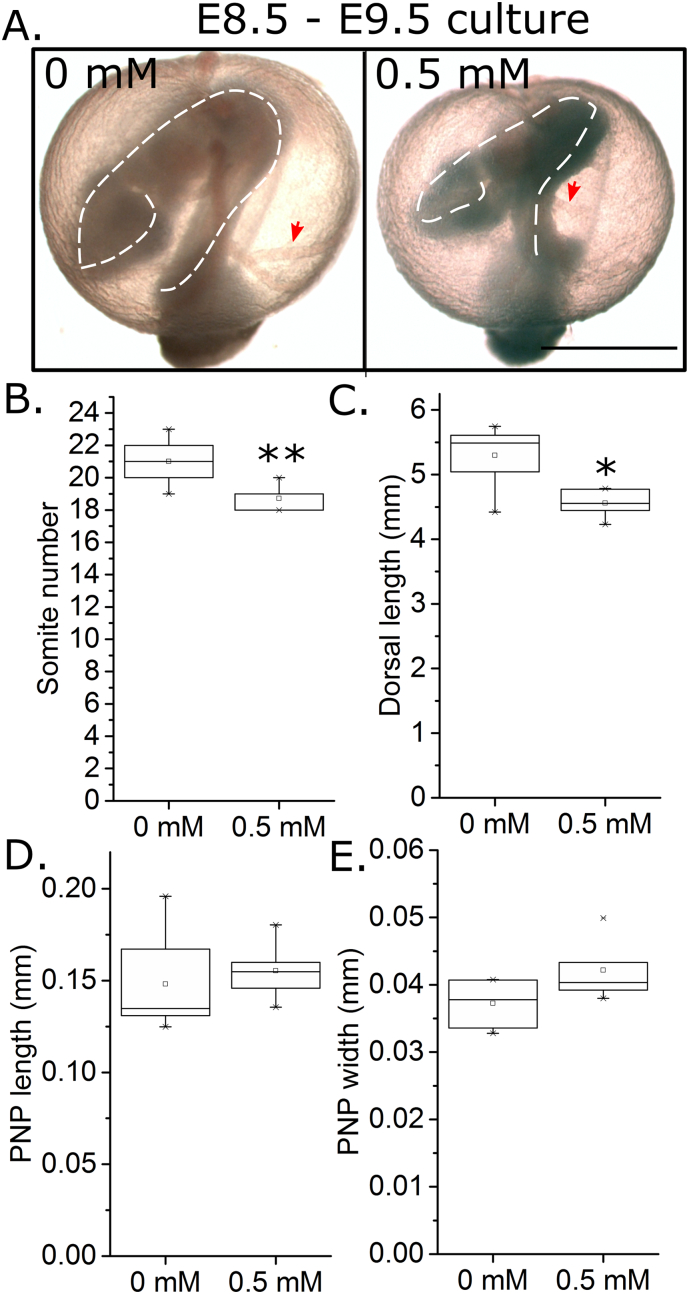
Valproic acid exposure in early neurulation diminishes embryo growth. A) Representative images of CD1 embryos cultured for 24 h from E8.5 to E9.5 in 0 mM or 0.5 mM VPA (1 mM VPA decreased viability at this early developmental stage). The outline of the embryos (white dashed lines) and yolk sac vessels (red arrows) are indicated. Scale bar = 1 mm. B) Somite number was quantified in all cultured embryos at the end of culture and was significantly diminished by 0.5 mM VPA treatment, n = 8 per group. C–E) Comparing embryos which reached 19–22 somite stage at the end of culture (n = 5–6), 0.5 mM VPA treatment significantly diminished dorsal length (C) without altering PNP length (D) or width (E). *p < 0.05, **p < 0.01.